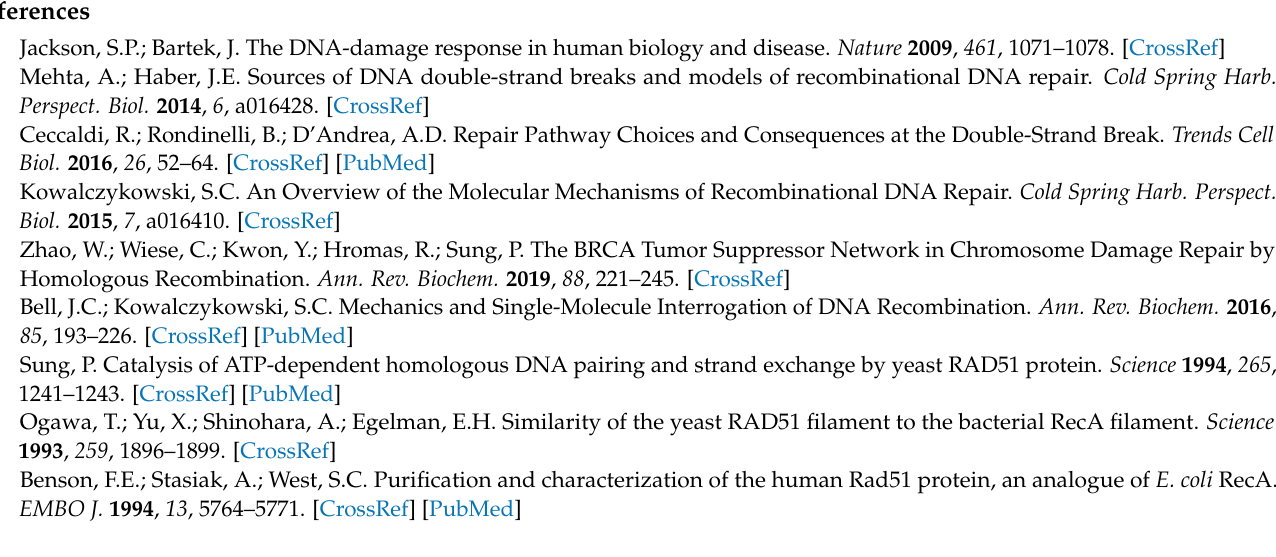
Figure S2: Effect of B02 Derivatives with Phenyl group modifications on HR in U-2 OS IndDR-GFP human cells, Figure S3: Scheme of the synthesis of p-formyl-benzyl derivative of B02, Figure S4: Scheme of the synthesis of B02-iso and derivatives (compounds 6a-g), Figure S5: B02-iso does